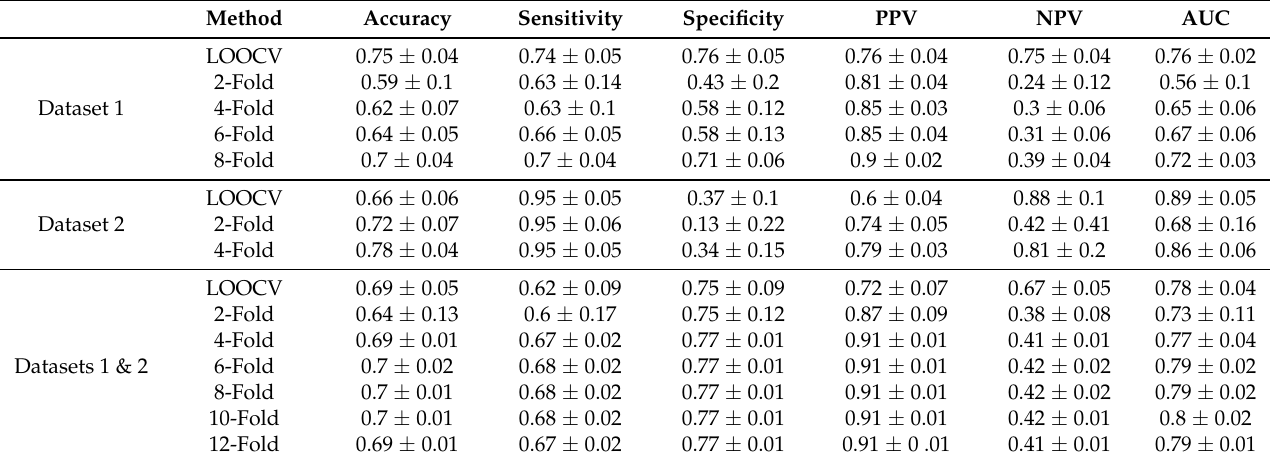
Table 2. Validated predictive performance of best